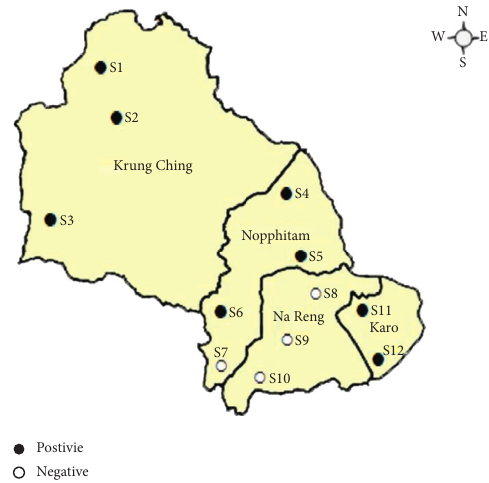
Figure 1: Map of Nopphitam district in Nakhon Si Thammarat province highlighting the distribution of positive (black circle) and negative (white circle) sites for Toxocara eggs in soil